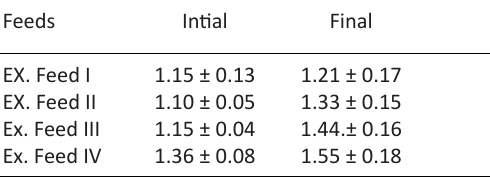
Table 7. Condition factor(K) of Blue Gourami Feeds